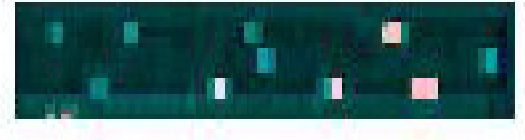
Figure 18: Dark Vehicle Detected Image